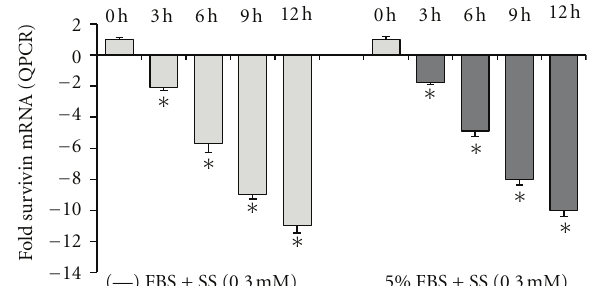
Figure 4: Survivin mRNA down-regulation by sulindac sulfide in serum-free and serum-containing media. Real-time quantitative PCR analysis showed that the rate and extent of downregulation of survivin mRNA levels in the presence of sulindac sulfide were similar over time in serum-free media and serum-containing media. ∗ Indicates significantly reduced survivin mRNA levels relative to 0 hours, P < 0 .